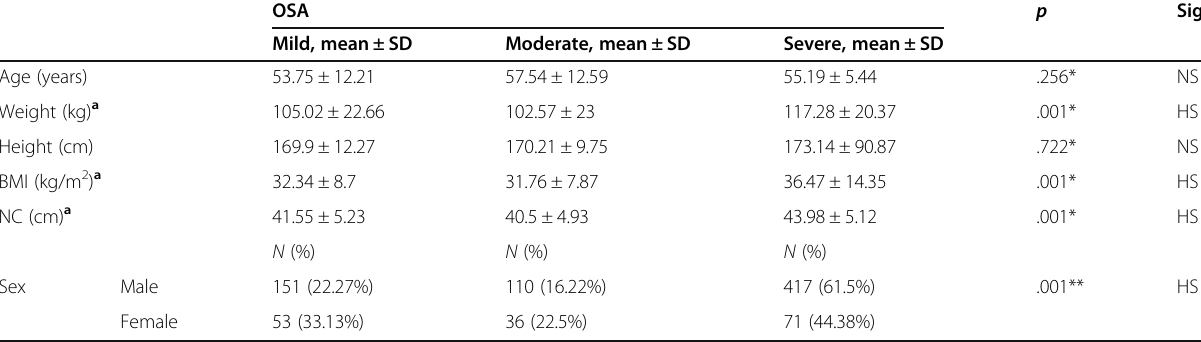
Table 3 Comparison between patients with mild, moderate, and severe OSA